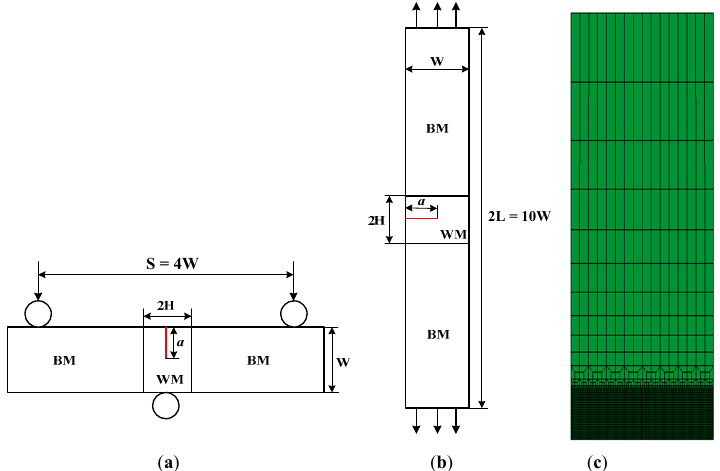
Figure 2. Schematic plots of the specimens, ( a ) single edge notched bending (SENB); ( b ) single edge notched tension (SENT); and, ( c ) finite element mesh.